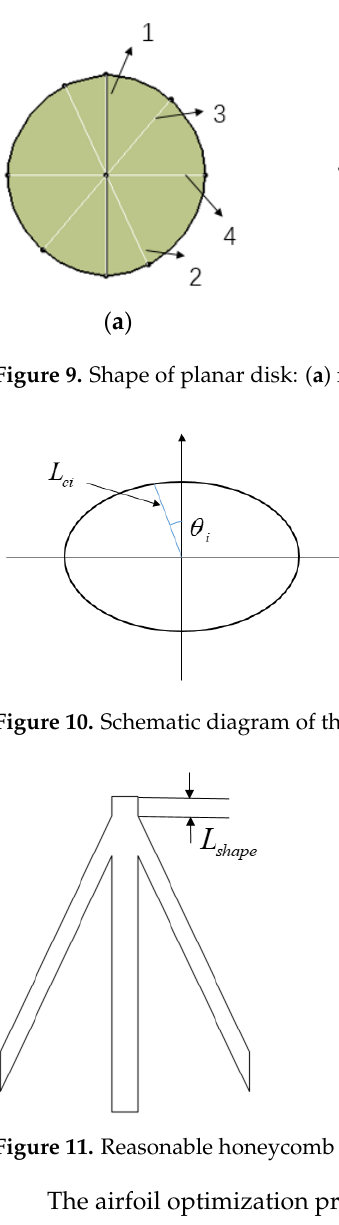
Figure 11. Reasonable honeycomb structure shape.